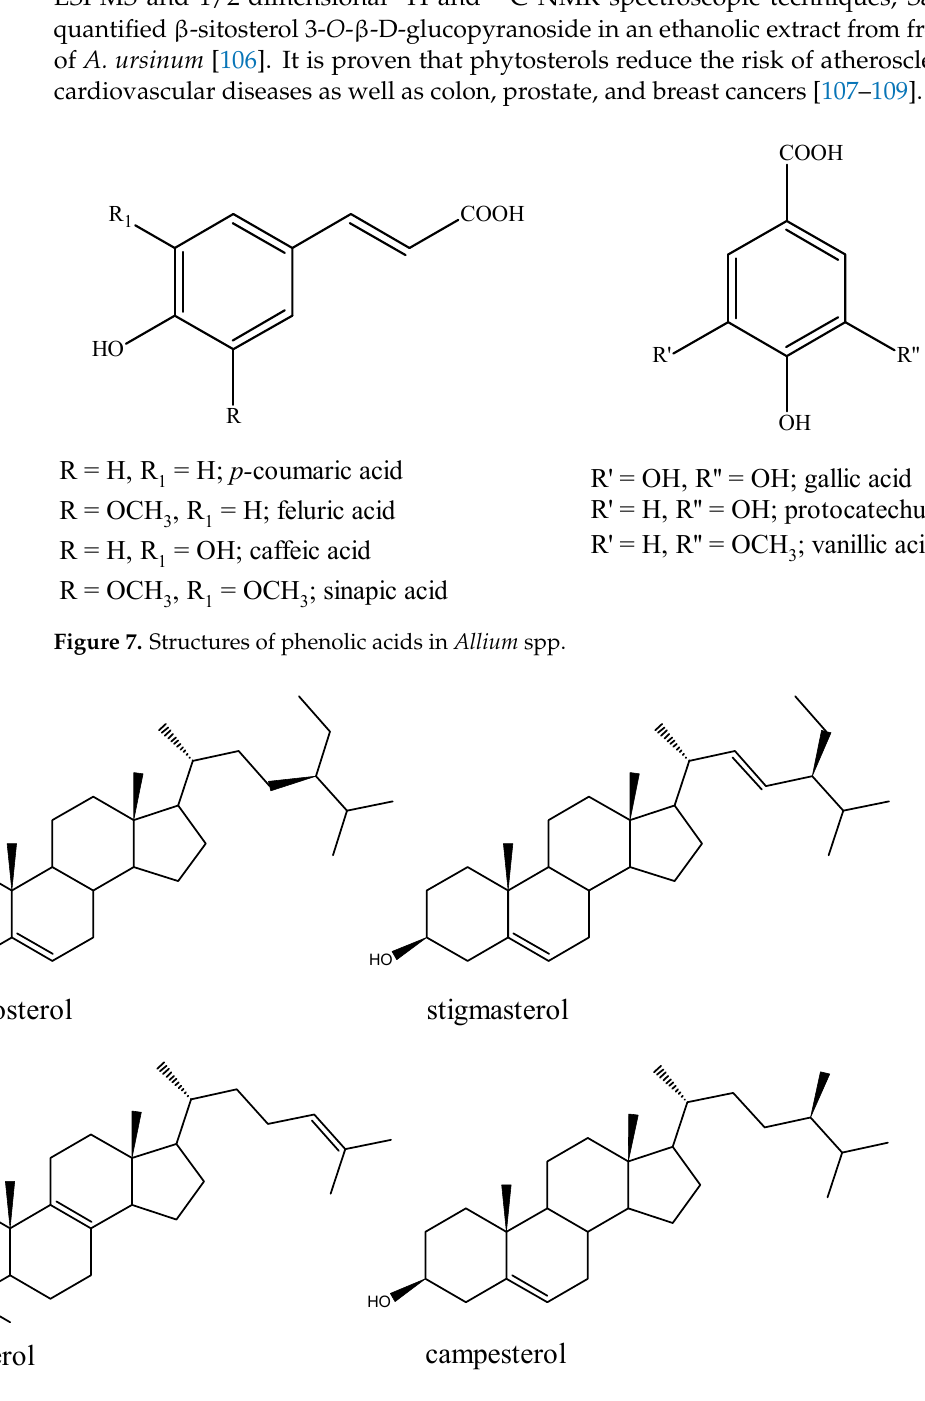
Figure 8. The structures of sterols identified in A. cepa . Sobolewska et al. [110] isolated two spirostanol saponosides from wild garlic ( A. ursi- num ), (25R)-spirost-5,25(27)-dien-3 β -ol 3- O - α -L-rhamnopyranosyl- (1 → 4)- α -L-rhamno- pyranosyl-(1 → 4)-[ α -L-rhamnopyranosyl-(1 → 2)]- D -glucopyranoside and (25R)-spirost-5- en-3 β -ol 3- O - α -L-rhamnopyranosyl-(1 → 4) - α -L-rhamnopyranosyl- (1 → 4)-[ α -L-rhamno- pyranosyl-(1 → 2)]- D -glucopyranoside (Figure 9) which show activity toward murine mel- anoma B16 and sarcoma XC. Additionally, a pregrane glycoside 3-hydroxy-pregna-5,16- dien- 20-on-3- O - α -L- rhamnopyranosyl-(1 → 4)- α -L- rhamnopyranosyl-(1 → 4)-[ α -L-rham- nopyranosyl-(1 → 2)]- β - D -glucopyranoside (Figure 9) was found in the bulbs of A. ursinum [110].